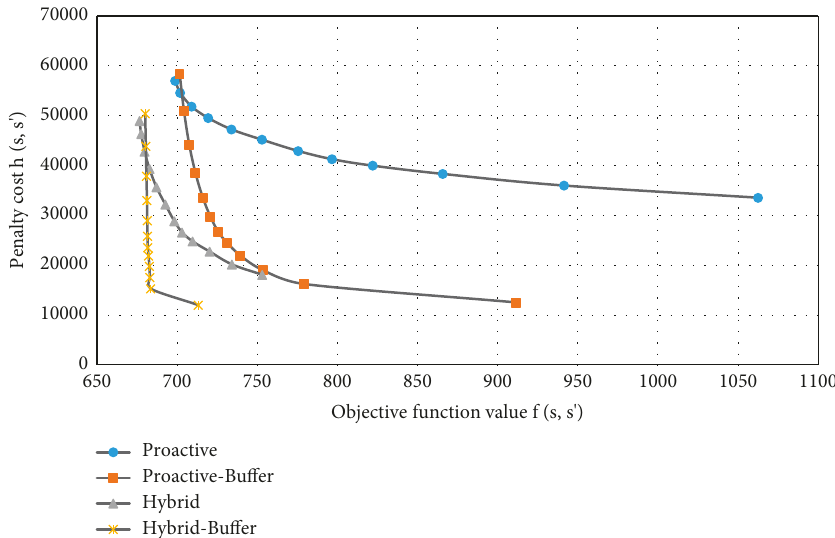
Figure 4: Performance comparison between proactive and hybrid solution